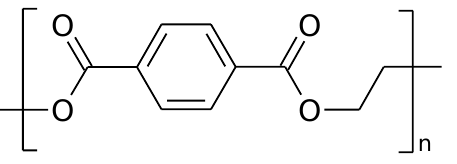
Figure 5. The fragment of polyethylene terephthalate structure.